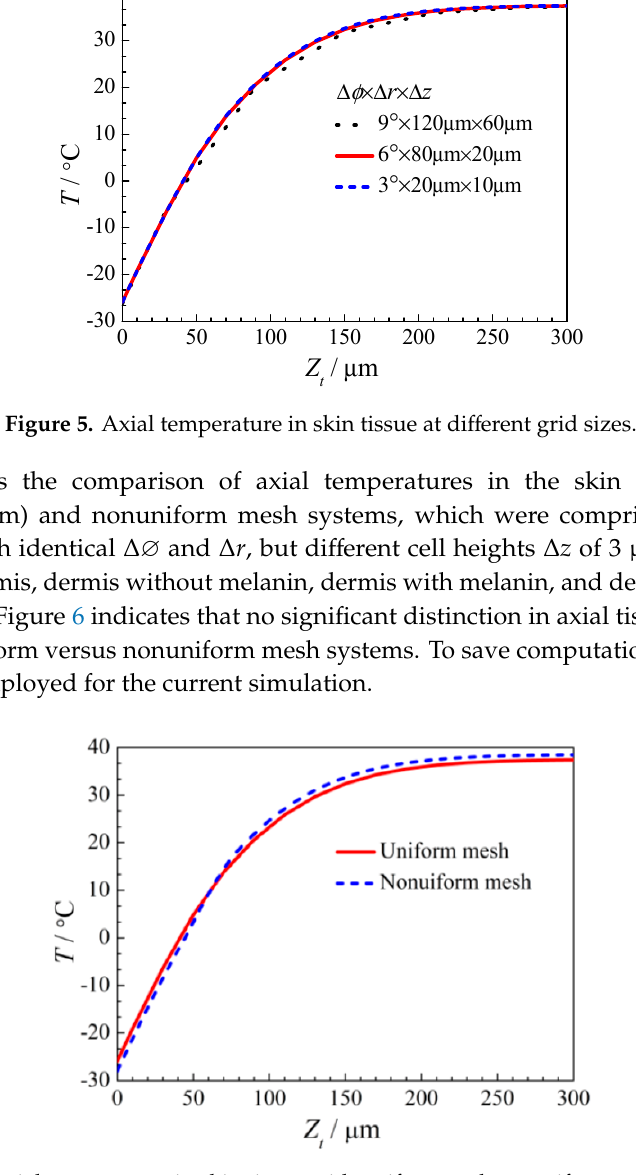
Figure 4. Axial droplet diameter distributions under different mesh sizes.